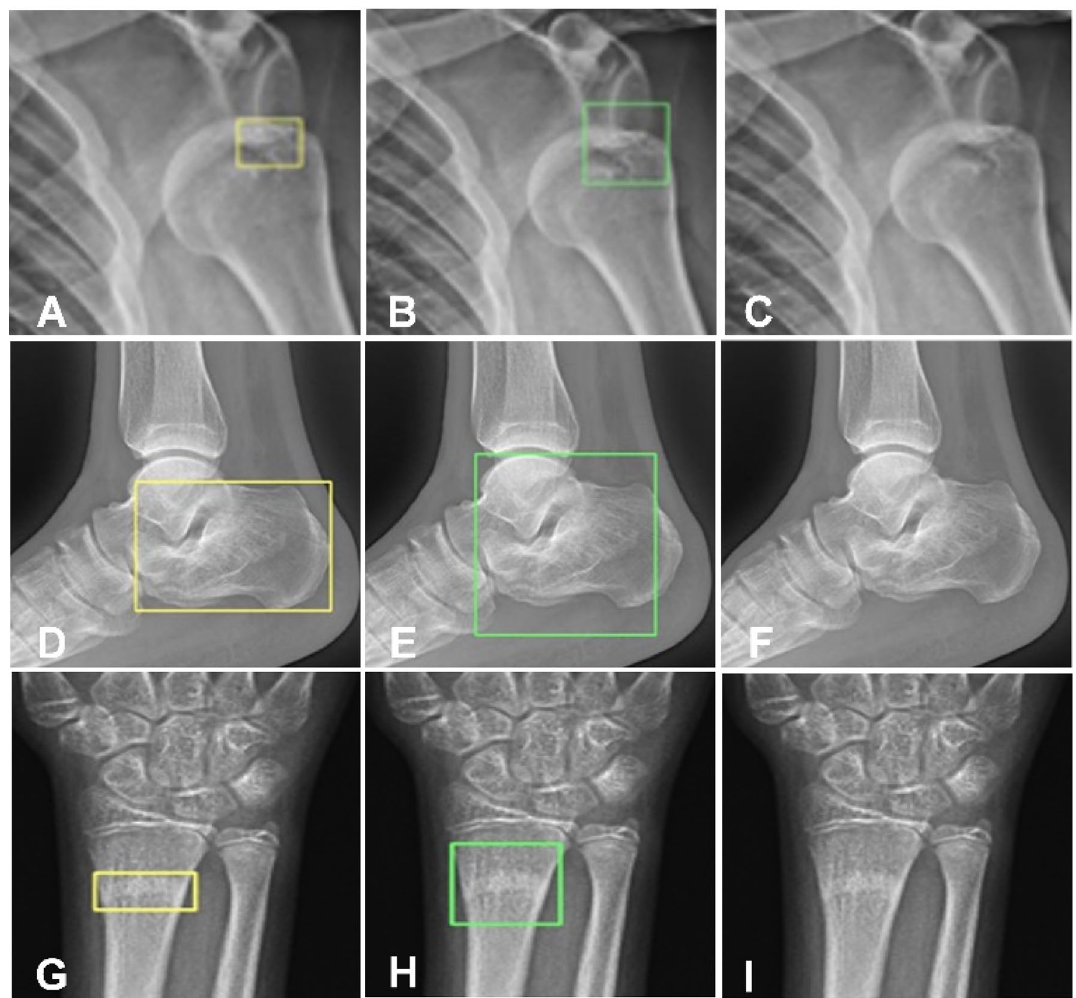
Figure 4. Effects of the Feature Ambiguity Mitigate Operator (FAMO) plus ResNeXt101+FPN model and the ResNeXt101+FPN model only, with the FAMO plus ResNeXt101+FPN model being helpful in finding bone fractures. ( A – C ) Dislocation of the left shoulder joint. ( A ) The radiologist correctly located the dislocation of the shoulder joint. ( B ) The FAMO plus ResNeXt101+FPN model also correctly pointed out the location of dislocation. ( C ) The ResNeXt101+FPN model only did not find the dislocation. ( D – F ) Compression fracture of the calcaneus. ( D ) The radiologist correctly found the fracture site. ( E ) The FAMO plus ResNeXt101+FPN model also correctly pointed out the fracture area. ( F ) The ResNeXt101+FPN model failed to find the fracture. ( G – I ) Radial embedded fracture. ( G ) The radiologist correctly found the embedded fracture. ( H ) The FAMO plus ResNeXt101+FPN model also correctly pointed out the fracture. ( I ) The ResNeXt101+FPN model failed to find the fracture.